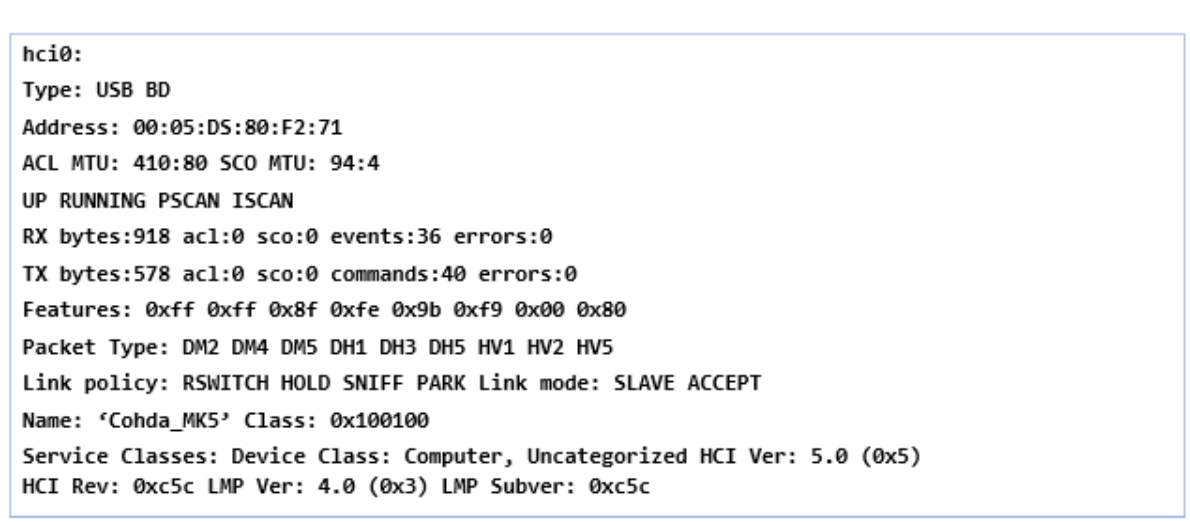
Figure 10. V2X communication diagram.